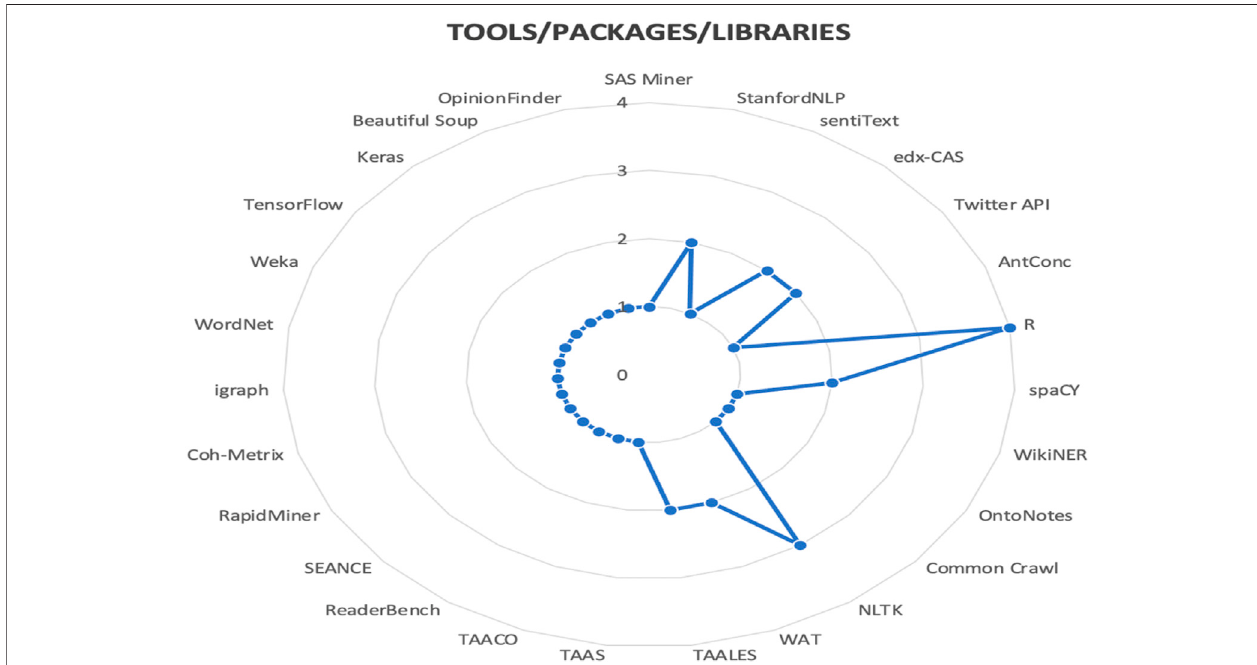
FIGURE 7 | Tools/packages/libraries/used for sentiment analysis in the reviewed papers.